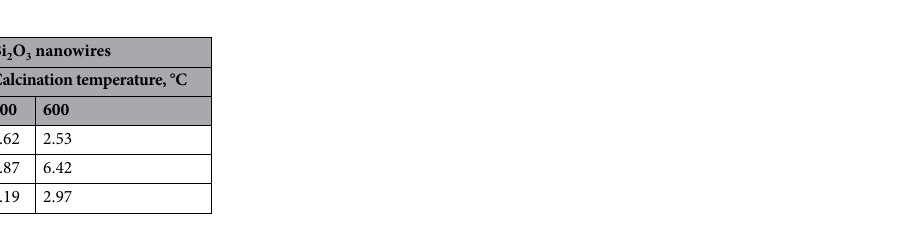
Table 1. Determined values of the complex refractive index, dielectric permittivity and energy gap width values obtained for the produced nanowires.